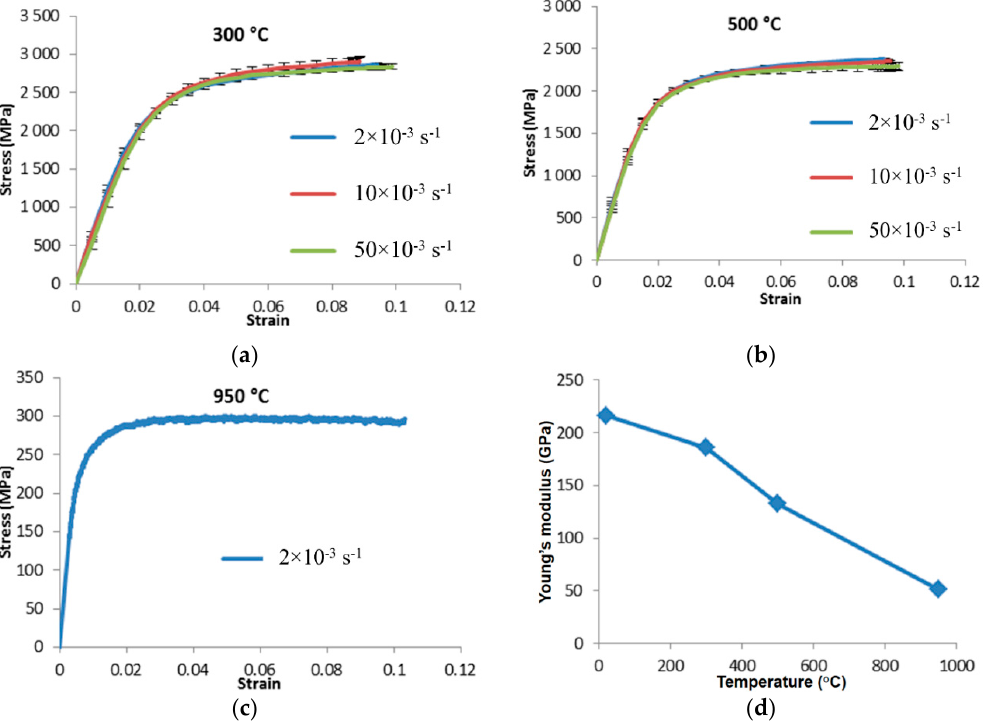
Figure 12. Stress–strain curves at different temperatures and strain rates: ( a ) 300 °C; ( b ) 500 °C; ( c ) 950 °C. ( d ) Elastic modulus dependence on temperature for M4 material obtained by directed energy deposition (DED).